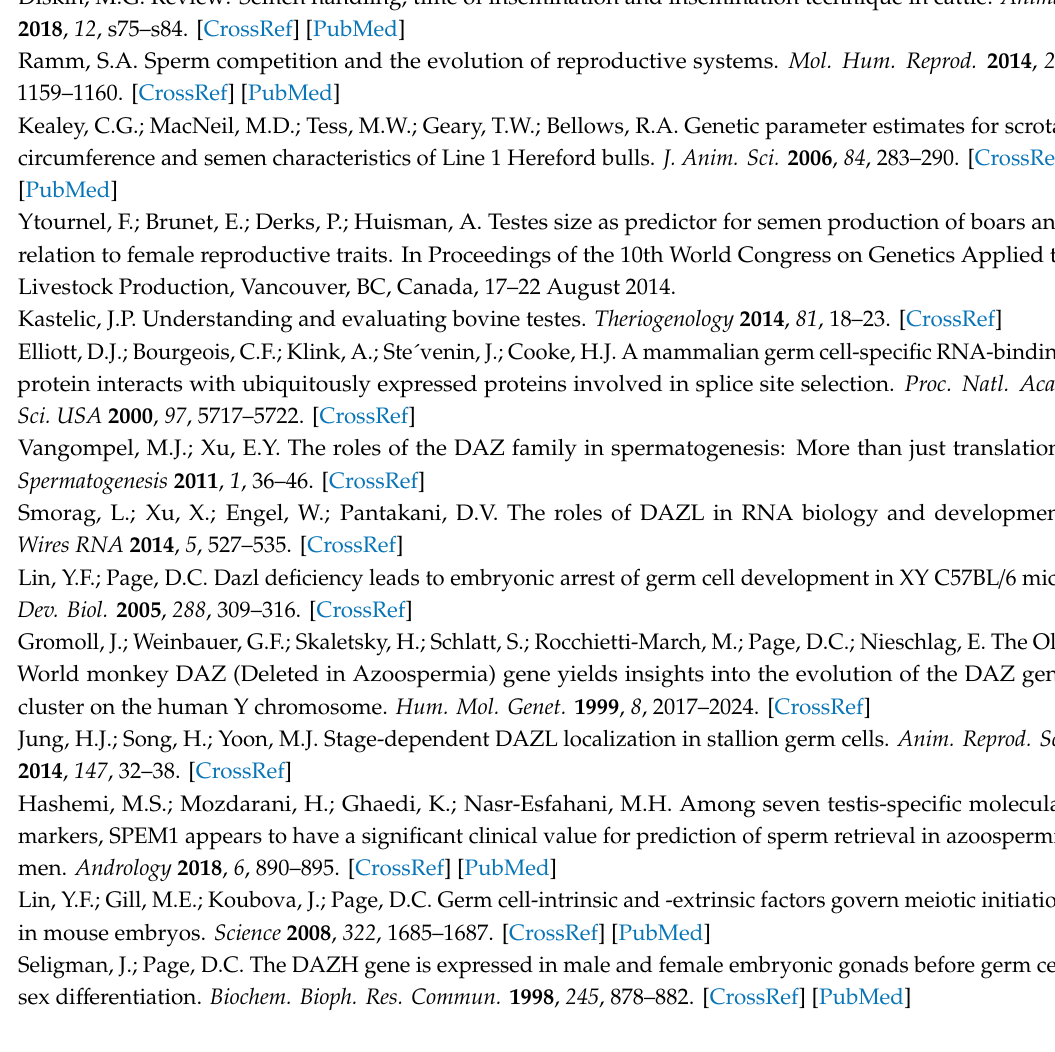
Figure S1: the sequencing results of six single nucleotide polymorphisms (SNPs). Table S1: Normality test for 13 phenotypes. Table S2: P values of Least Absolute Shrinkage and Selection Operator (LASSO) regression for 13